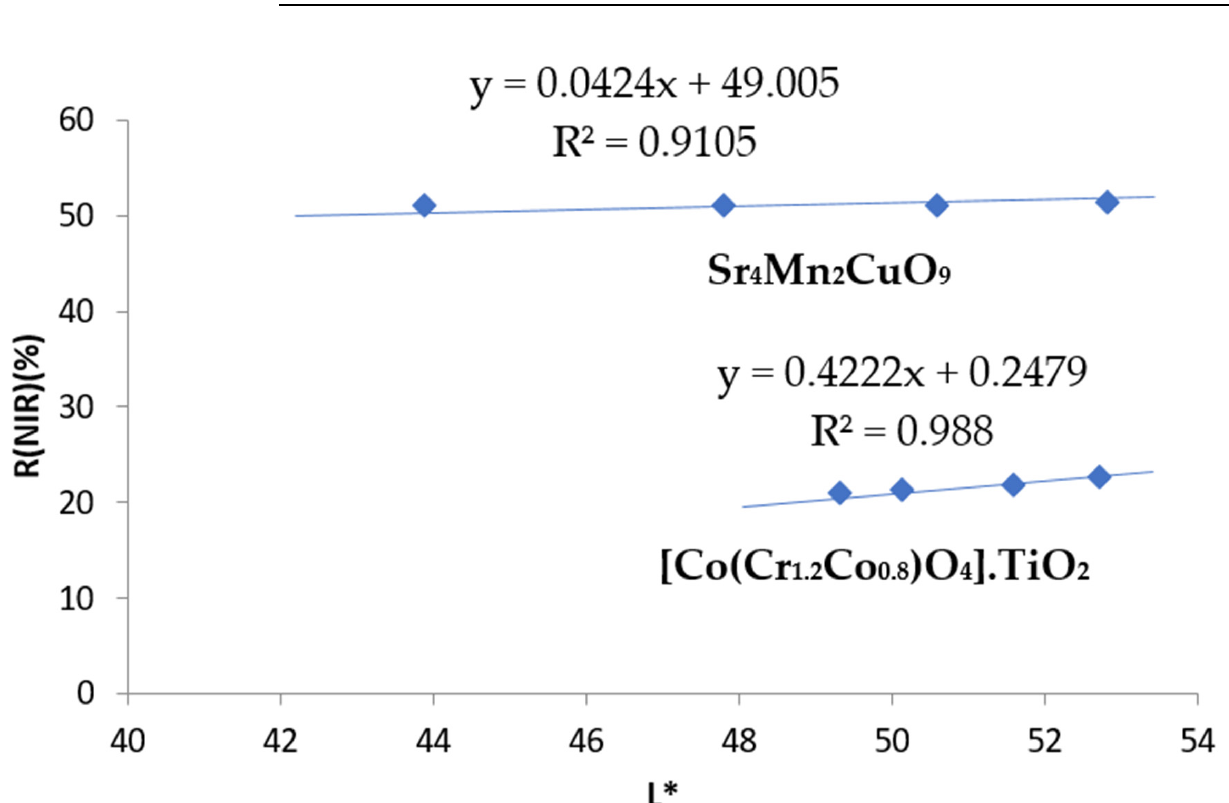
Figure 10. R NIR versus lightness L* of black pigments with gradual addition of the binder CaCO 3 .